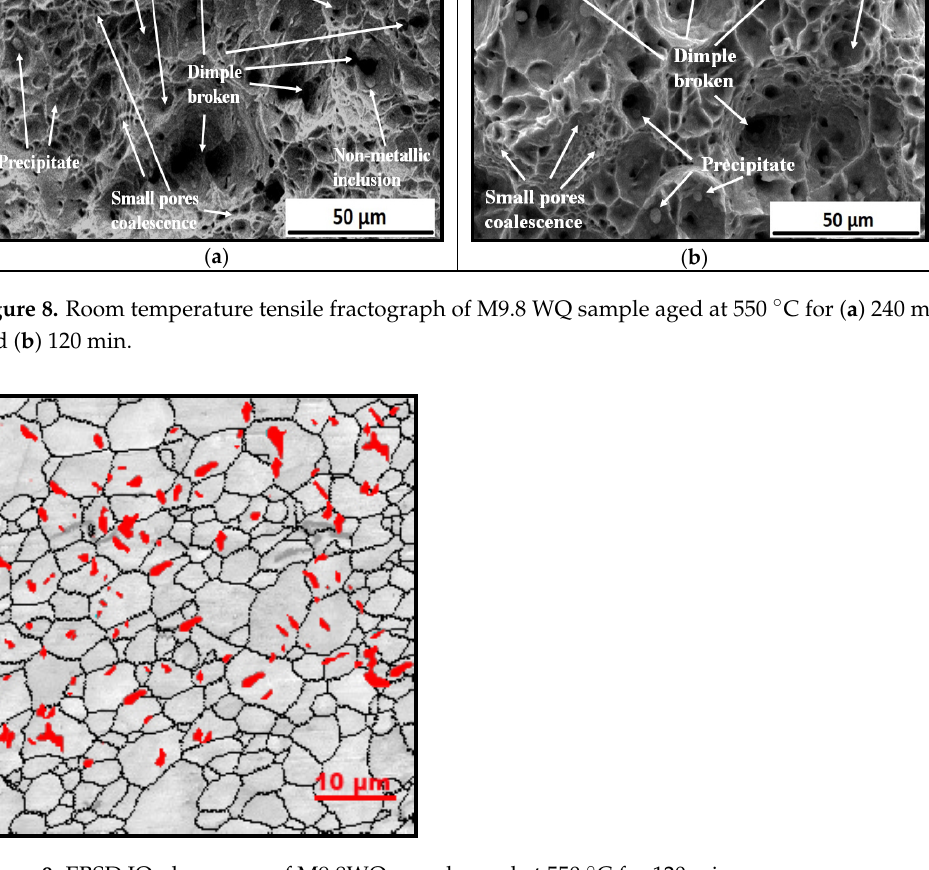
Figure 9. EBSD IQ phase map of M9.8WQ sample aged at 550 °C for 120 min.